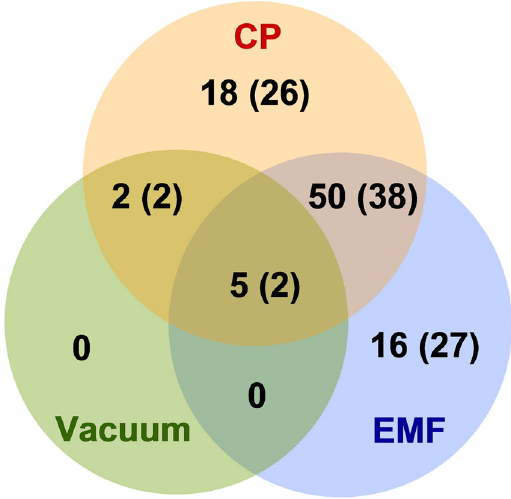
Figure 2. Venn diagram of protein abundance differences (p < 0.01 and > 1.5-fold variations) in the sunflower shoots germinated from seeds treated with vacuum, CP or EMF radiation. Numbers outside and inside brackets indicate differences when the treated experimental group is compared to untreated control or vacuum treated experimental groups, respectively.